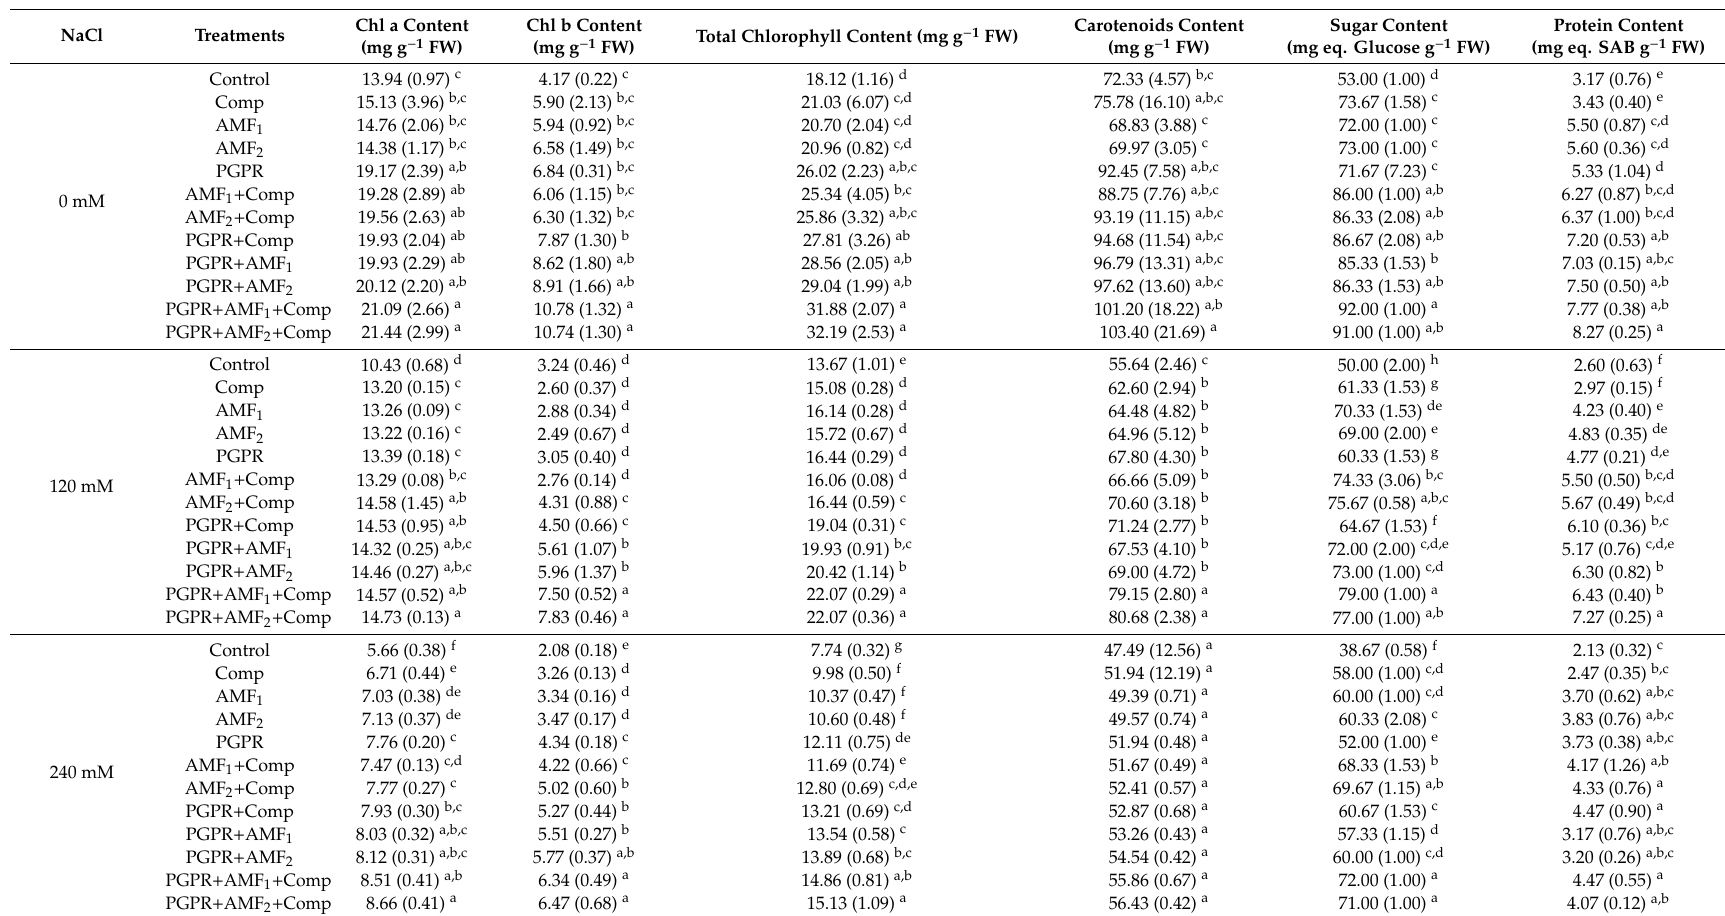
Table 4. E ff ects of biofertilizers on sugar, protein and photosynthetic pigment contents of date palm vitroplants.